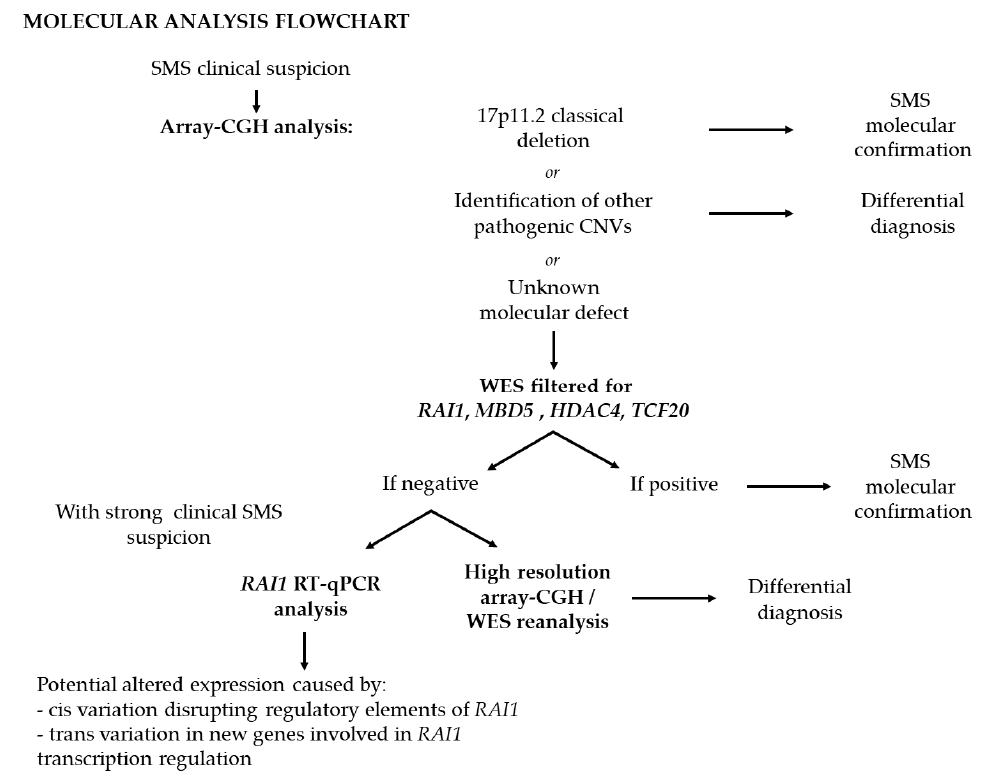
Figure 4. Suggested diagnostic approach for